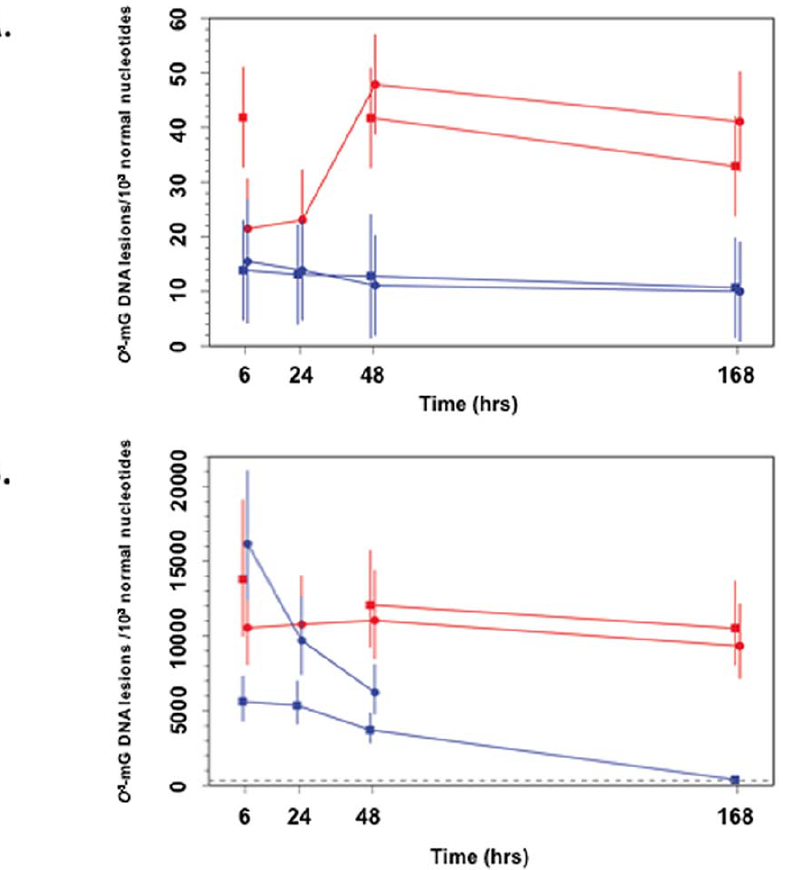
Figure 2. Time-course of O 6 -methylguanosine ( O 6 -mG) DNA damage in the brain (A) and liver (B) of wt (blue) and Mgmt 2 / 2 (red) mice following a single intraperitoneal dose of MAM. Results for the two study sites are shown as separate red and blue lines. The plotting symbols (OHSU: circle; FHCRC: square) denote the estimated medians; lines extend 6 2 standard errors from the medians. DNA damage ( O 6 -mG) is three orders of magnitude higher in the liver than in brain, and the significantly elevated O 6 -mG levels in Mgmt 2 / 2 vs. wt tissues at 48 hr are maintained at 168 hr post MAM treatment. Discontinuities in the red and blue lines are attributed to technical errors or where samples were not collected. The dashed gray line in B denotes the maximum observed O 6 -mG level in the brain ( , 330 lesions per 10 8 normal nucleotides).